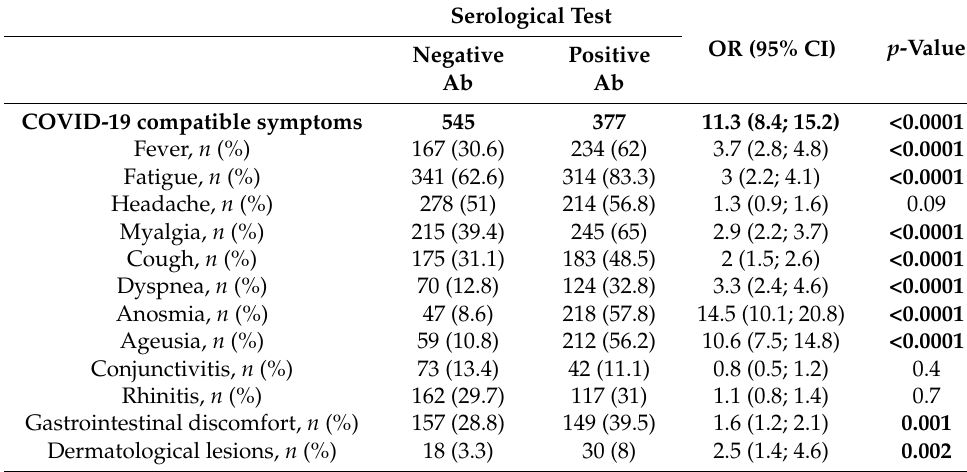
Table 3. Distribution and strength of association as odds ratios (OR) with 95% confidence interval (95% CI) of signs and symptoms with detectable SARS-CoV-2 IgG